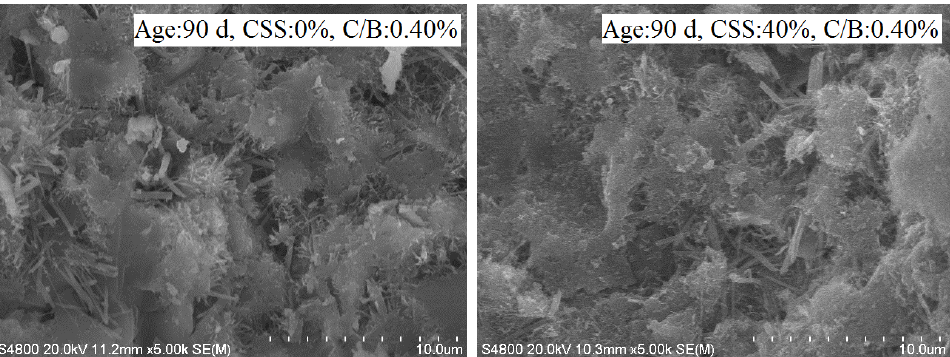
Figure 9. Micromorphologies of the samples.